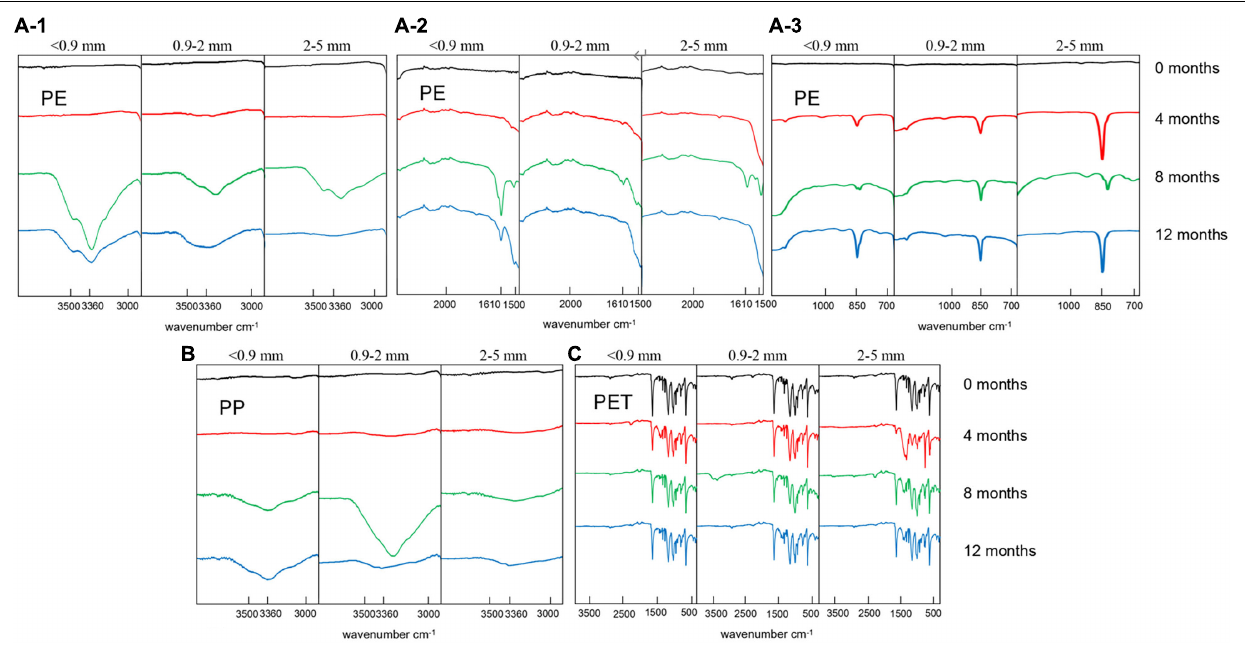
FIGURE 1 | Selection of FTIR spectra of PE, PP, and PET microplastics surfaces with different aging time.